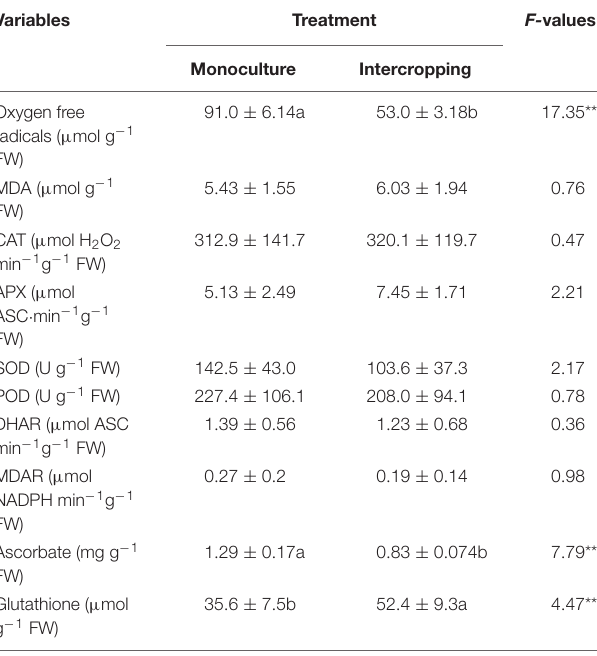
Different letters in the same row indicate statistically significant differences at the level of ≤ 0.05. *P < 0.05, **P < 0.01, and ***P < 0.001. MDA, Malondialdehyde; CAT, Catalase; APX, Ascorbate peroxidase); POD, Peroxidase; SOD, Superoxide dismutase; DHAR, Dehydroascorbate reductase; MDAR,